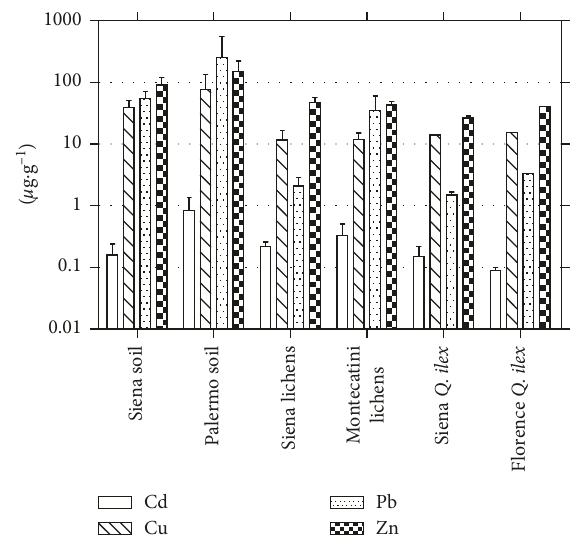
Figure 1: Average metal concentrations ± SD ( μ g · g − 1 d.w.) in soil, epiphytic lichens, and holm oak live foliage from Siena and other urban areas in Italy (data sources: Palermo [34]; Montecatini [35], Florence